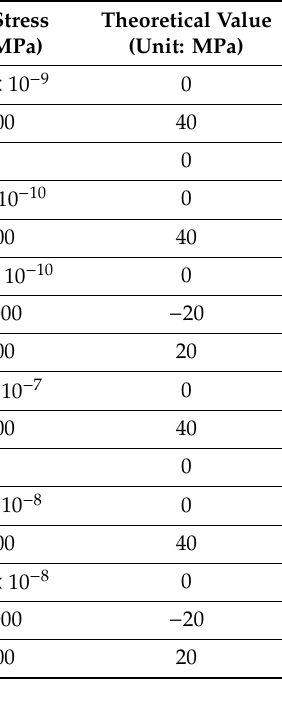
Table 5. The element elastic stress field at the selected iteration